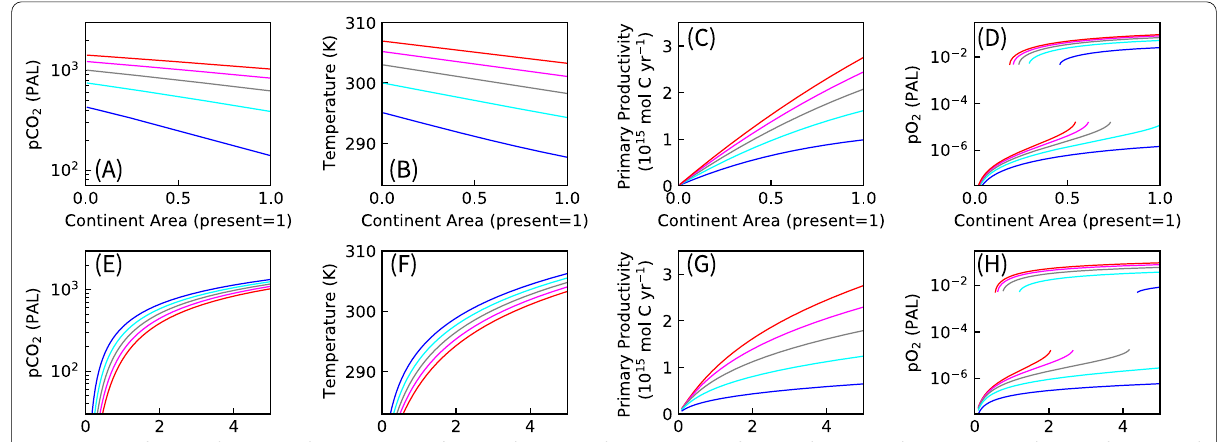
Fig. 3 Response of the system against continental growth with Proterozoic-like ecosystem. The dependence of p CO 2 , surface temperature, export production rate, and p O 2 (PAL) on the continental area ( A – D ) and CO 2 outgassing flux ( E – H ), calculated for low primary productivity of anaerobic photoautotrophs ( F red 7.50 10 10 mol C year –1 ), bioavailable fraction of the riverine phosphorus ( γ bio 1), solar luminosity (83% of present = × = Earth), seafloor spreading rate (1.307 times the present rate), and soil biological activity ( f e 0.15). A – D The dependence on the continental area at = different CO 2 outgassing rates. Steady states for 1, 2, 3, 4, and 5 times the present CO 2 outgassing rate are shown with blue, cyan, grey, pink, and red lines, respectively. E – H The dependence on CO 2 outgassing rate at different continental areas. Steady states for 0.2, 0.4, 0.6, 0.8, and 1.0 times the present continental area of the Earth are shown with blue, cyan, grey, pink, and red lines,